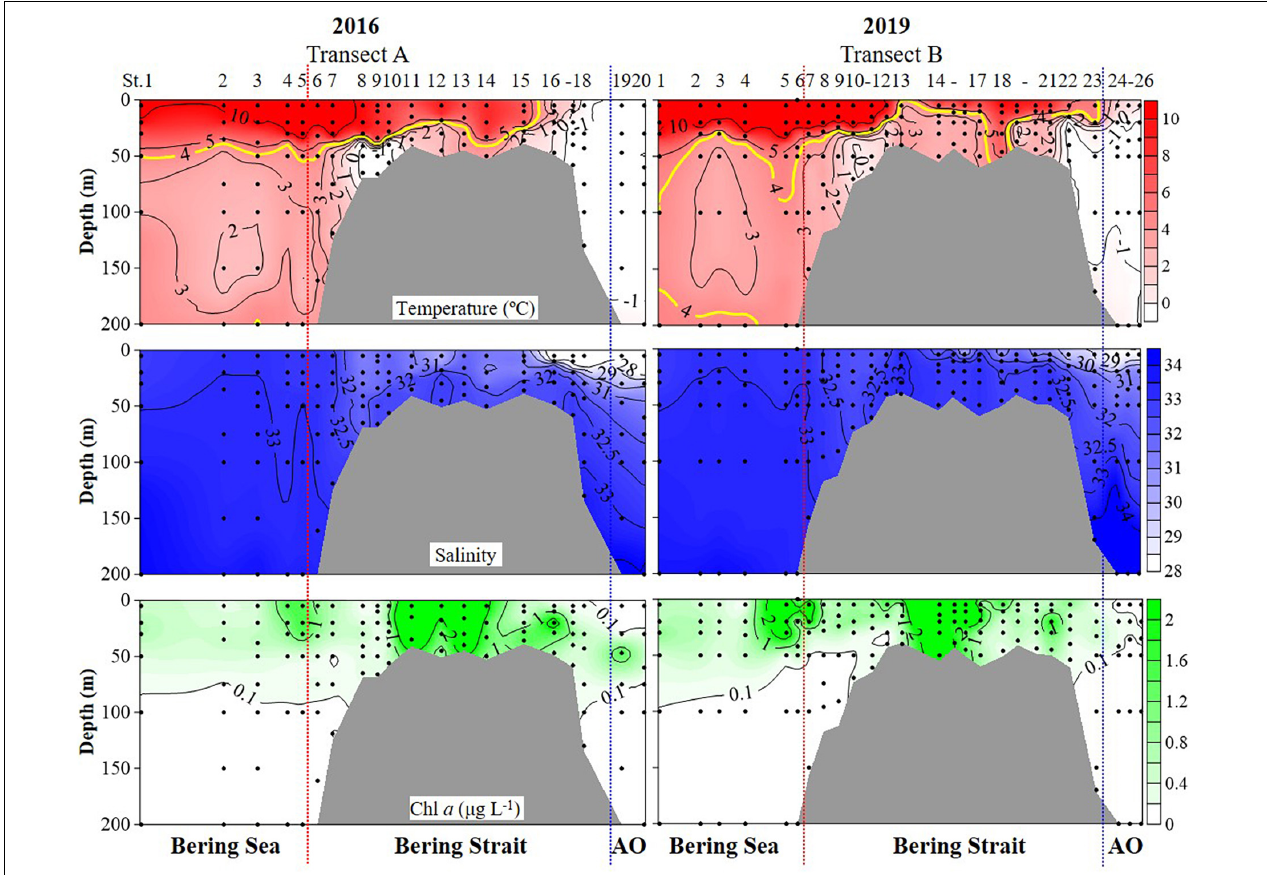
FIGURE 2 | Temperature, salinity, and Chlorophyll a (Chl a ) profiles from surface to bottom (or 200 m). Black dots, sampling points; red dotted line, boundary between the Bering Sea and Bering Strait; blue dotted line, boundary between the Bering Strait and Arctic Ocean (AO).